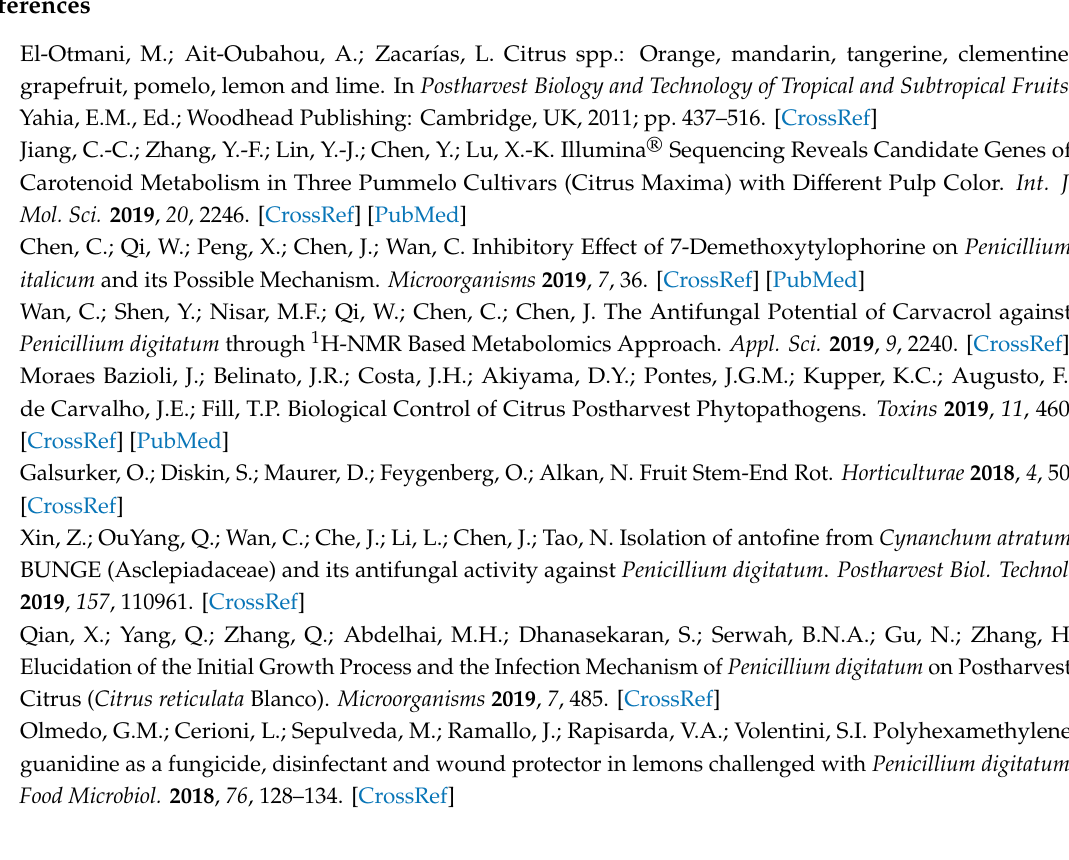
Figure S1. A volcano plot of all metabolite ions.; Table S1. Metabolites identified by UPLC-Q-TOF-MS of Penicillium digitatum mycelia treated with pinocembroside